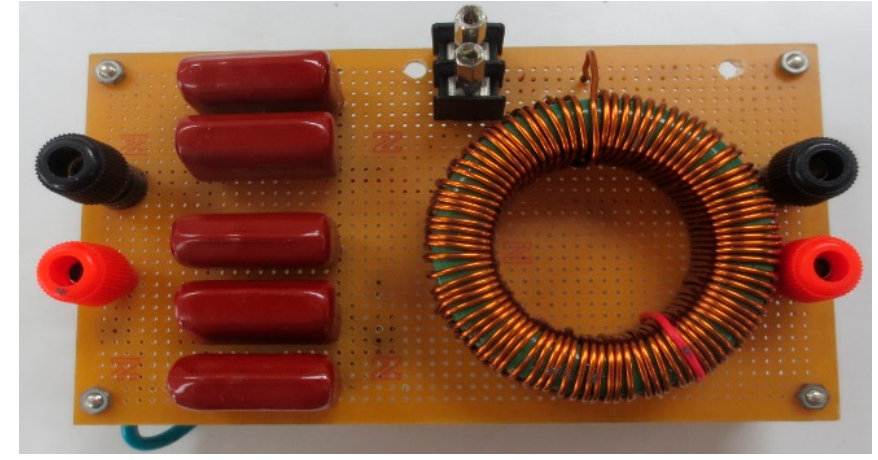
Figure 14. Low pass filter circuit.